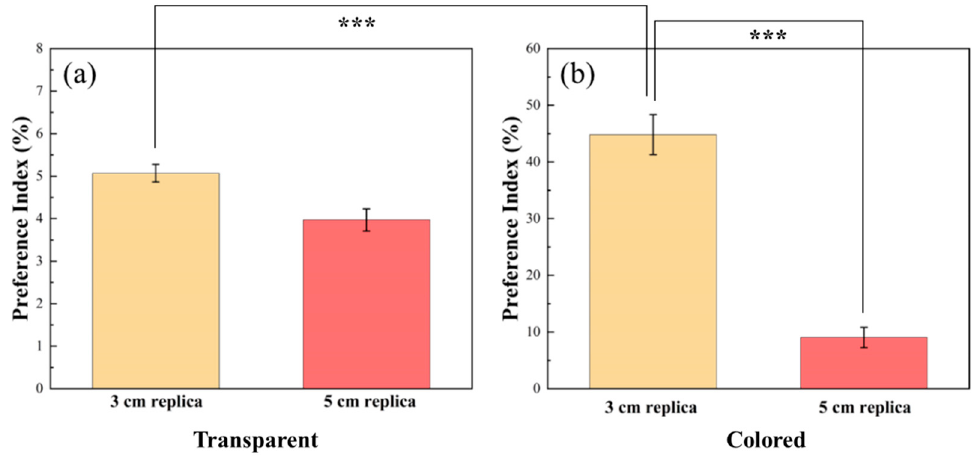
Figure 9. Preference index for ( a ) transparent and ( b ) colored replicas of different sizes (*** indicates p < 0.001).